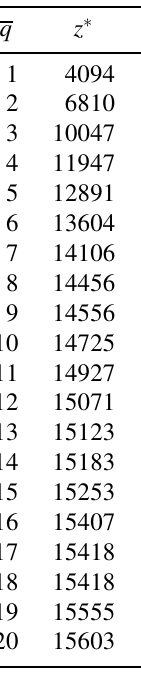
Table 4. Computational results for C 1